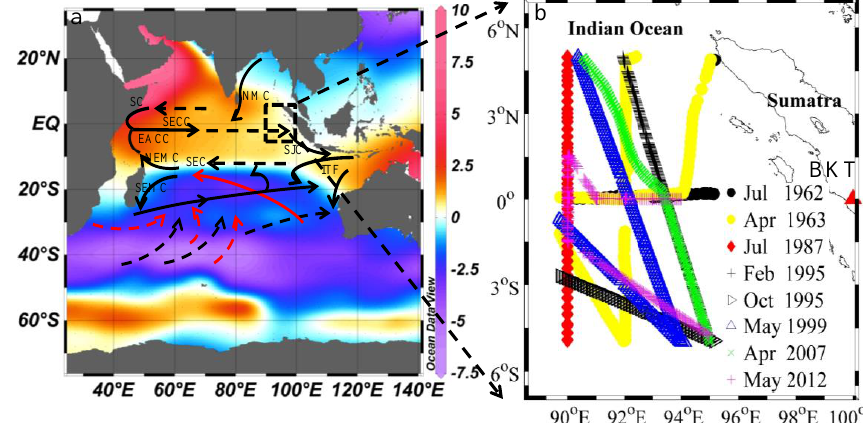
Figure 1. Study site (a) shows the relative location of the study site (within the dashed frame) in the Indian Ocean, annual air–sea CO 2 fluxes (molCm − 2 yr − 1 , colored) estimated by Takahashi et al. (2009), and schematic representations of ocean currents during the winter monsoon, redrawn from Schott et al. (2009). The currents shown in this map include the South Equatorial Current (SEC), South Equatorial Countercurrent (SECC), Northeast and Southeast Madagascar Current (NEMC and SEMC), East African Coastal Current (EACC), Somali Current (SC), Indonesian Throughflow (ITF), South Java Current (SJC), the Northeast Monsoon Current (NMC) during the winter monsoon, and so on. The subsurface return flow for the supergyre is shown in red. (b) shows the study site, the eastern equatorial Indian Ocean (EIO, 5 ◦ N–5 ◦ S, 90–95 ◦ E). The lines show all cruise tracks for surface CO 2 partial pressure ( p CO 2 ) measurements during the 1962–2012 period in the EIO. The red triangle presents the location of the atmospheric CO 2 observation station in Bukit Kototabang, Indonesia (BKT, 0.20 ◦ S, 100.38 ◦